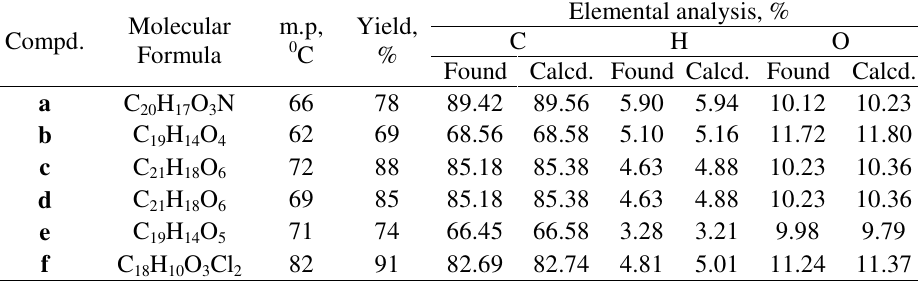
Table 1 . Characterization data of the compounds ( a-f ) Elemental analysis,